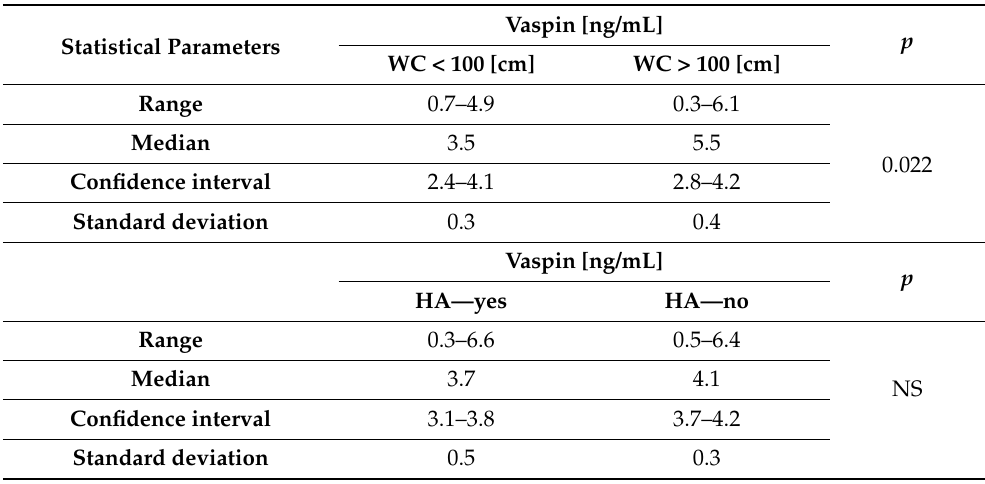
Figure 1. A strong correlation was found between BMI and serum vaspin levels (r = 0.658). Statistically significant correlations were also noted between patients with a waist circumference below and above 100 cm ( p = 0.022). The median value of serum vaspin con- centrations was higher among patients with waist circumference above 100 cm (5.5 ng/mL) compared to the patients with waist circumference below 100 cm (3.5 ng/mL). With regard to the median serum concentration of vaspin was lower among patients with hypertension (3.7 ng/mL) compared to the group of patients with proper blood pressure (4.1 ng/mL). This result was not statistically significant. Statistically significant differences were not revealed between median concentration of serum vaspin in the group of patients diagnosed with type 2 diabetes (5.0 ng/mL) versus patients without this chronic disease (5.1 ng/mL). Results are presented in Table 5. Table 5. Serum vaspin concentrations in female patients depending on WC: WC, waist circumference; HA, arterial hypertension; DM type 2, diabetes mellitus type